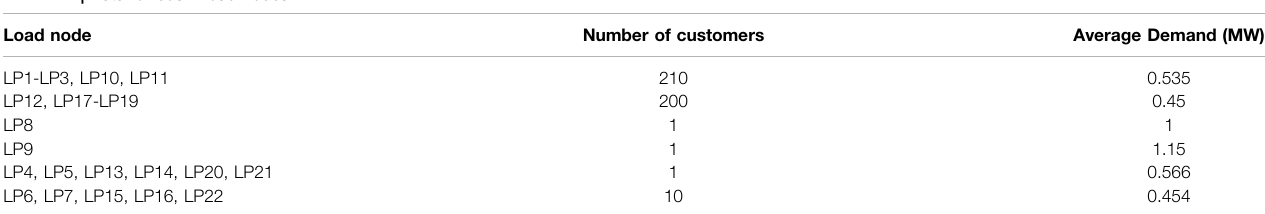
TABLE 2 | Data for bus 2 load nodes.